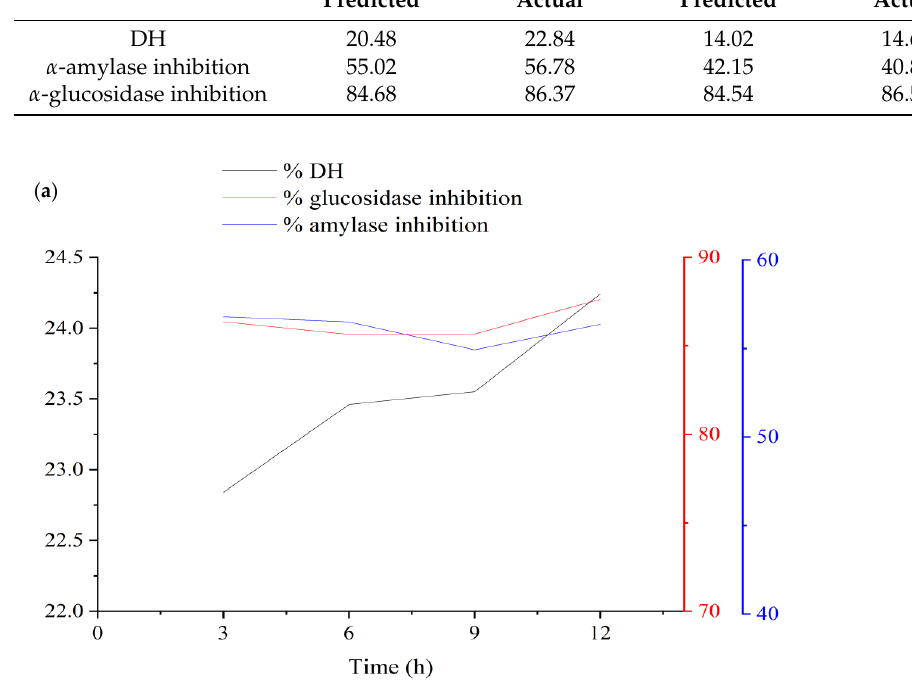
Table 4. Actual and predicted values observed during validation experiments under optimal conditions. Parameters